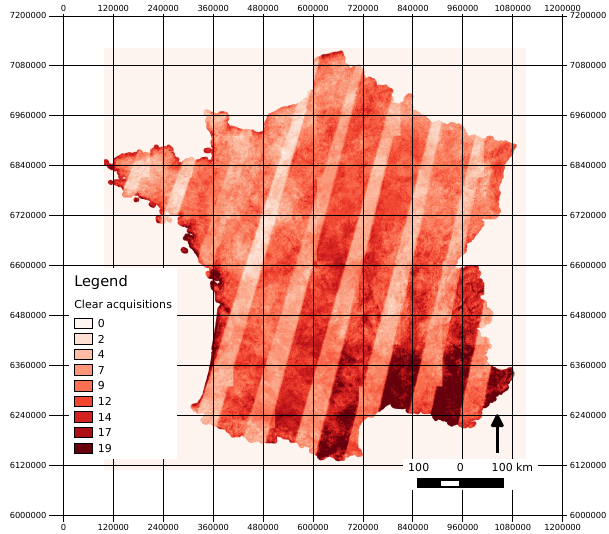
Figure 8. Map of the number of times that every pixel sees the ground taking into account satellite revisit and cloud